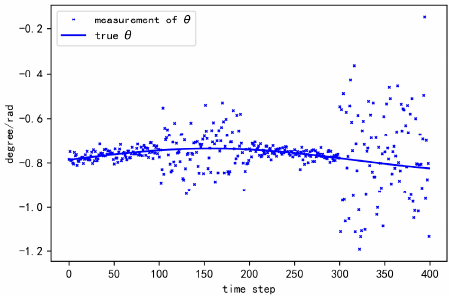
Figure 4. The heading angle observation of the cooperative vehicle in HV coordinate frame.